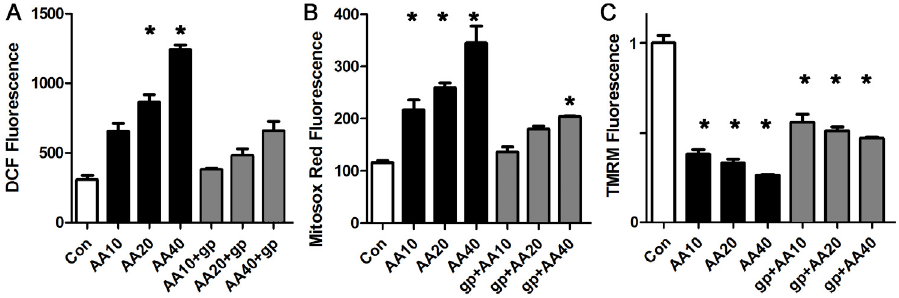
Fig 7. Blocking electron transport chain with antimycin-A causes ROS and mitochondrial depolarization. A. Representative experiment done with cardiomyocytes in triplicate, height is DCF fluorescence minus background, in live cells, mean + SEM expressed in arbitrary units. B. Cardiomyocytes from the same experiment using mitosox red readout. C. Cardiomyocytes from the same experiment using TMRM signal. For all panels, means are significantly different by ANOVA, * = sig different from control by post-hoc test. gp = gp91ds peptide 50 μ M, AA = antimycin-A at 10, 20 or 40 μ M.